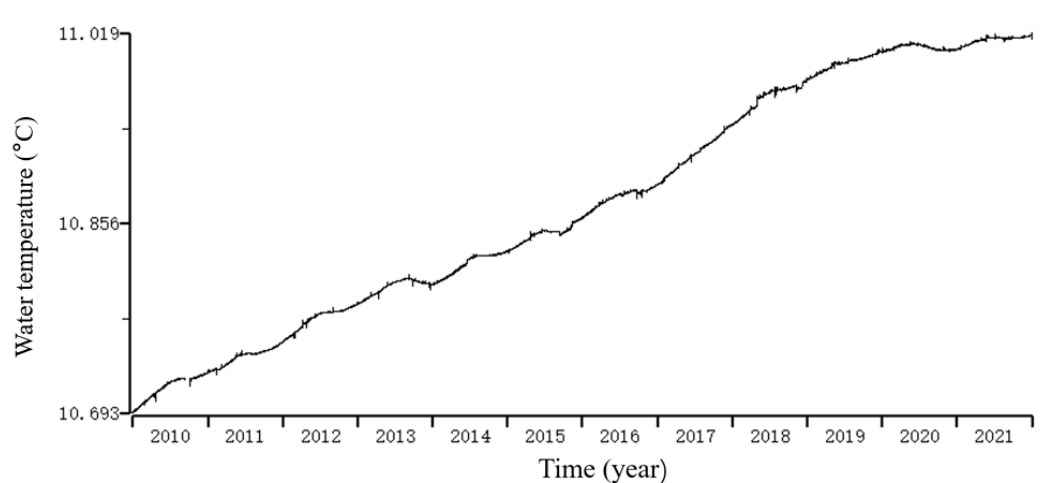
Figure 5. Annual dynamic characteristics of water temperature (unit: ◦ C) over the period from 2010 to 2021.